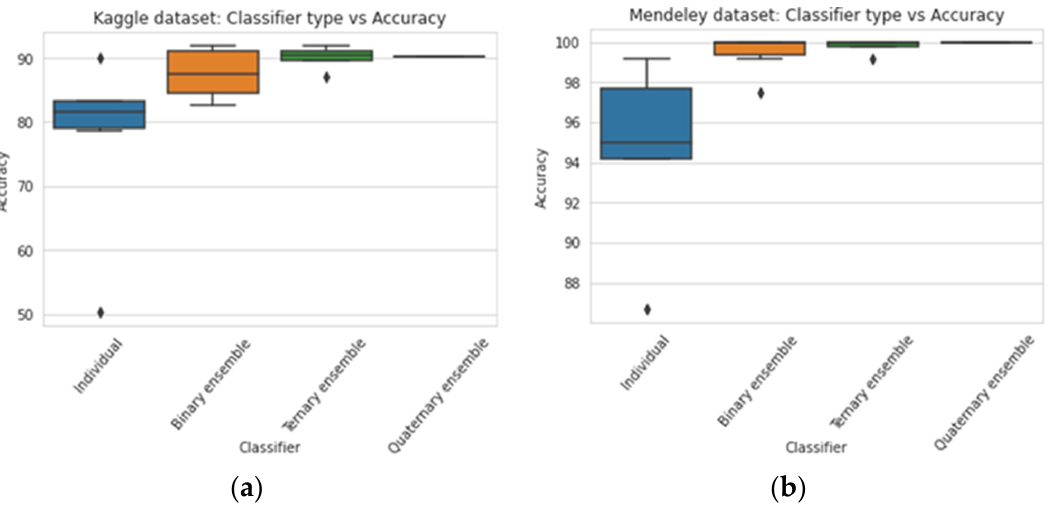
Figure 11. Range of accuracies of various classification models for ( a ) Kaggle and ( b ) Mendeley.